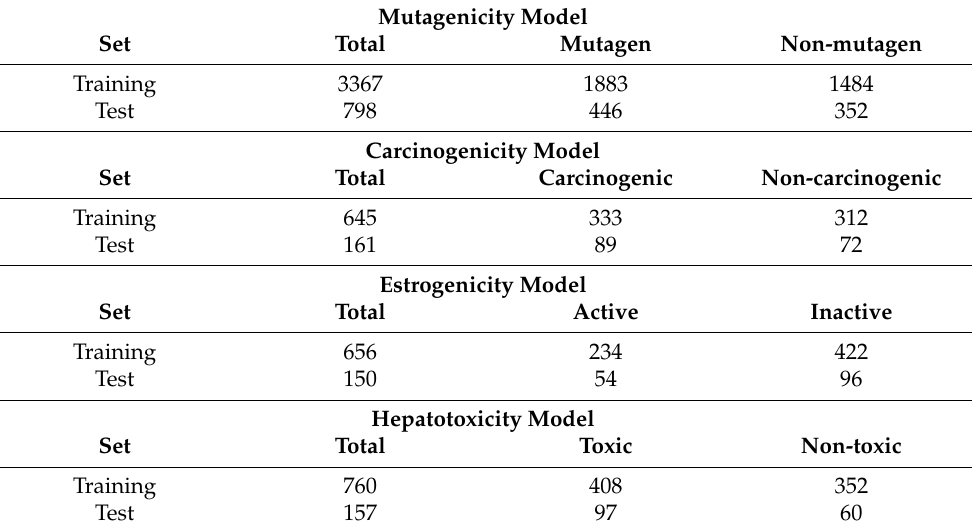
Table 1. Total number of molecules present in each training and test set, including their classification according to experimental value, was employed for model building and